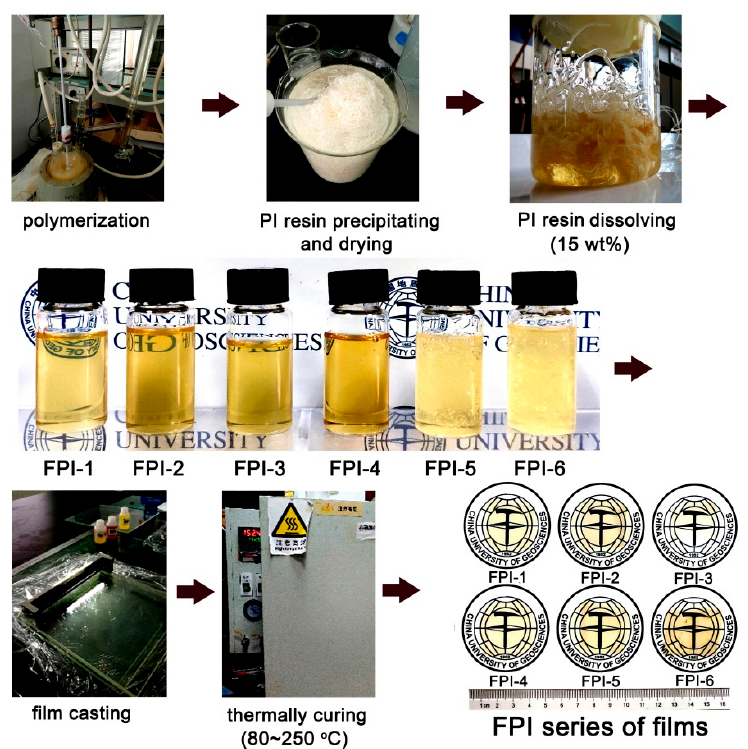
Figure 3. Preparation procedures of the FPI films.